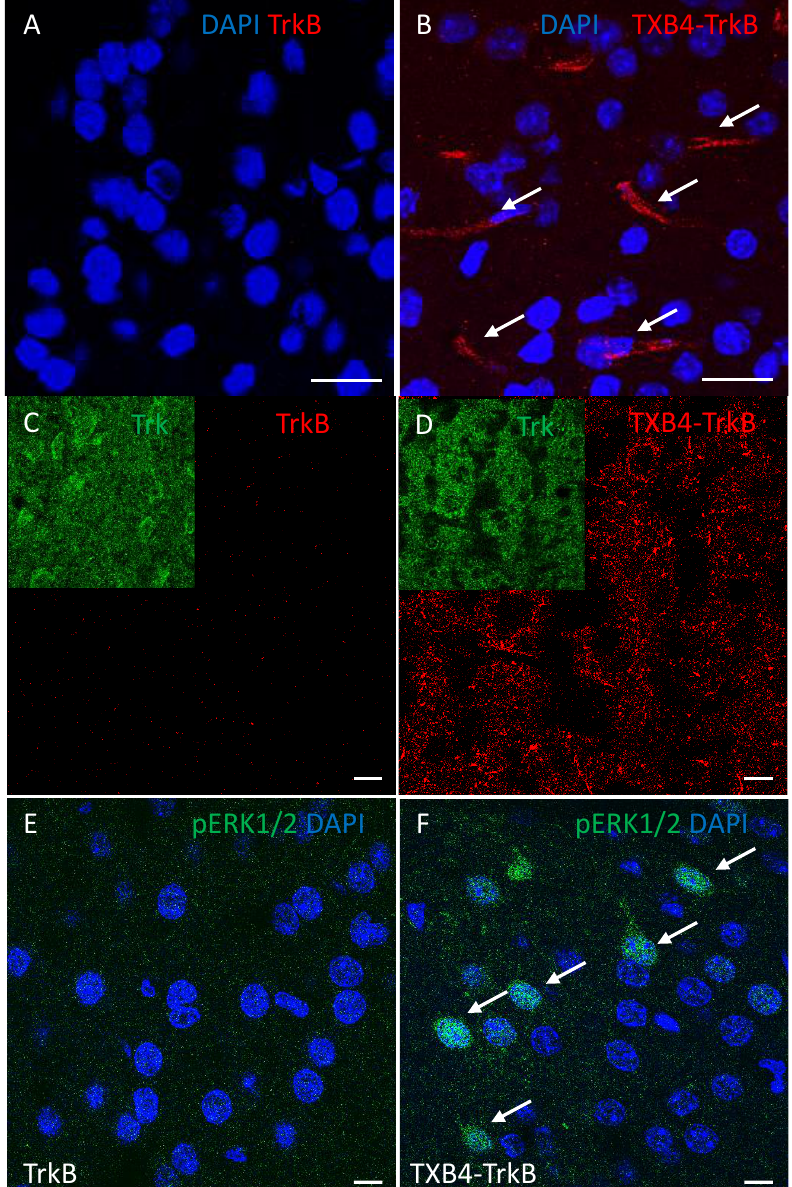
Figure 3. Brain localization of the TXB4-TrkB antibody fusion with ERK1/2 activation after